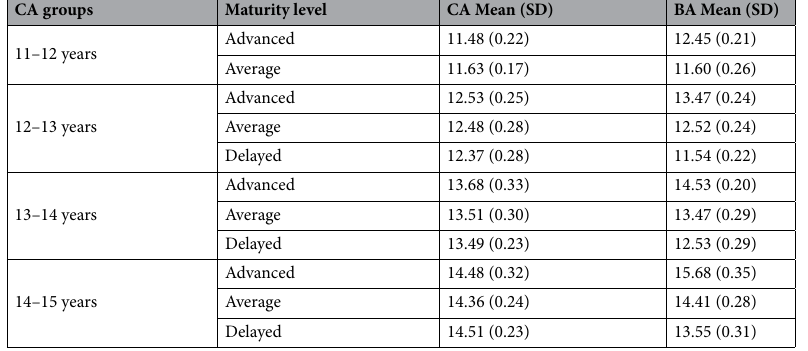
Table 3. Descriptive statistics of participants’ age. Descriptive statistics of the selected 117 participant cohort in terms of CA and BA. Maturity levels are grey-level-coded according to Fig. 1b. Each CA group starts at the birthday and ends just before the birthday of a participant (e.g.: 11.00–11.99 year). BA determines bin-sizes in a similar manner. The exact number of participants in each bin is presented in Fig.